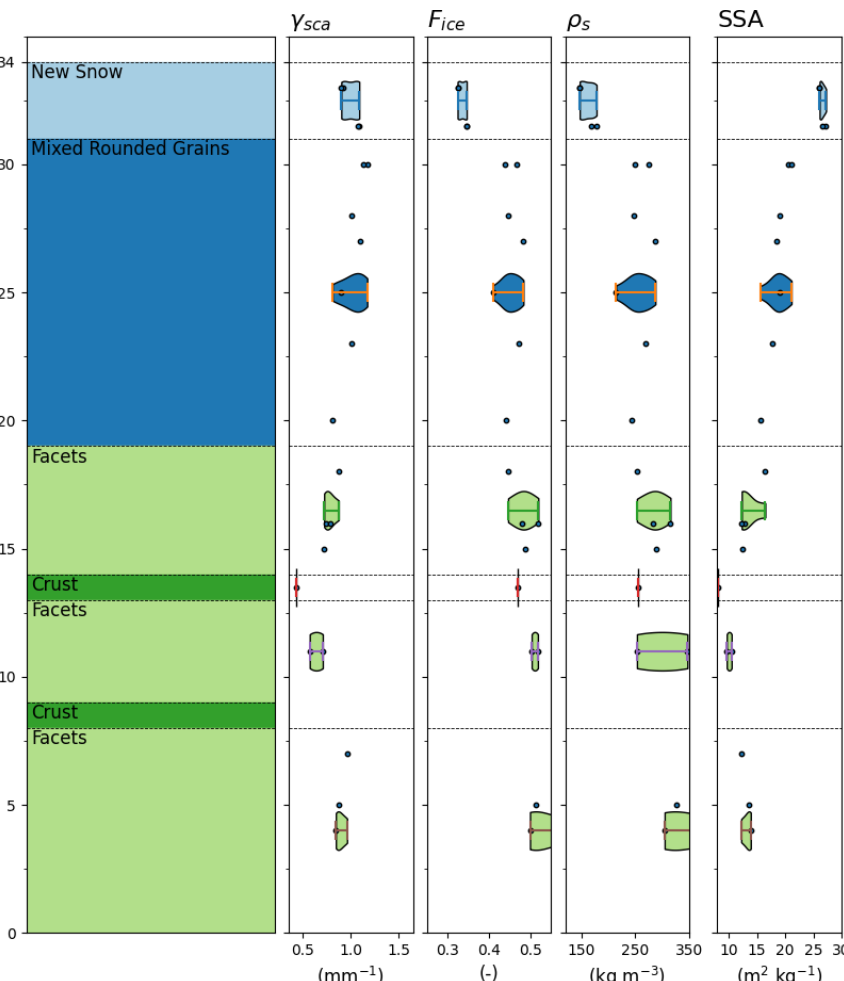
Figure 15. Snow pit stratigraphy (left) compared against γ sca , F ice , ρ s , and SSA. Each dot represents a µCT sample at a specified depth. Violin plots show estimated probability distributions for each observer-identified snow layer according to the samples collected with the